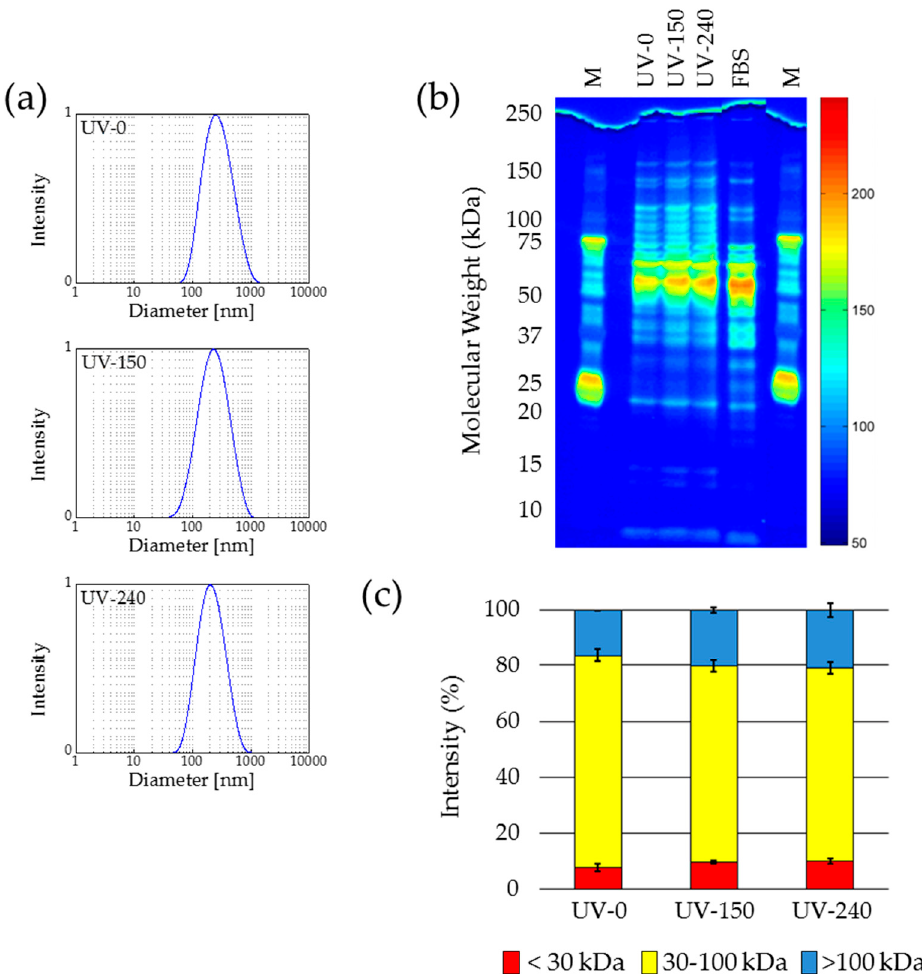
Figure 5. Ultraviolet (UV) sterilization of protein-coated nanoparticles does not affect the protein corona. ( a ) DLS measurements show that the hydrodynamic diameter of the protein-coated nanoparticles decreases with increasing treatment time ( b ) Protein size distribution is not altered as demonstrated by gel electrophoresis (silver staining and false color representation). ( c ) Variations of the protein size ranges over the storage period (based on ( b )). n = 3, M—protein size marker.